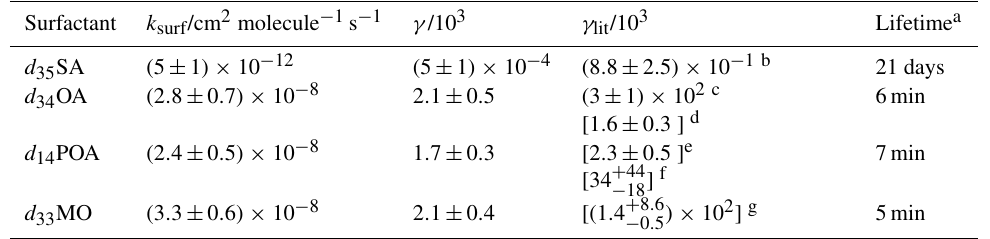
Table 3. Kinetic parameters, uptake coefficients and estimated monolayer lifetimes for the compounds studied. Literature values for uptake coefficients on similar compounds are included for